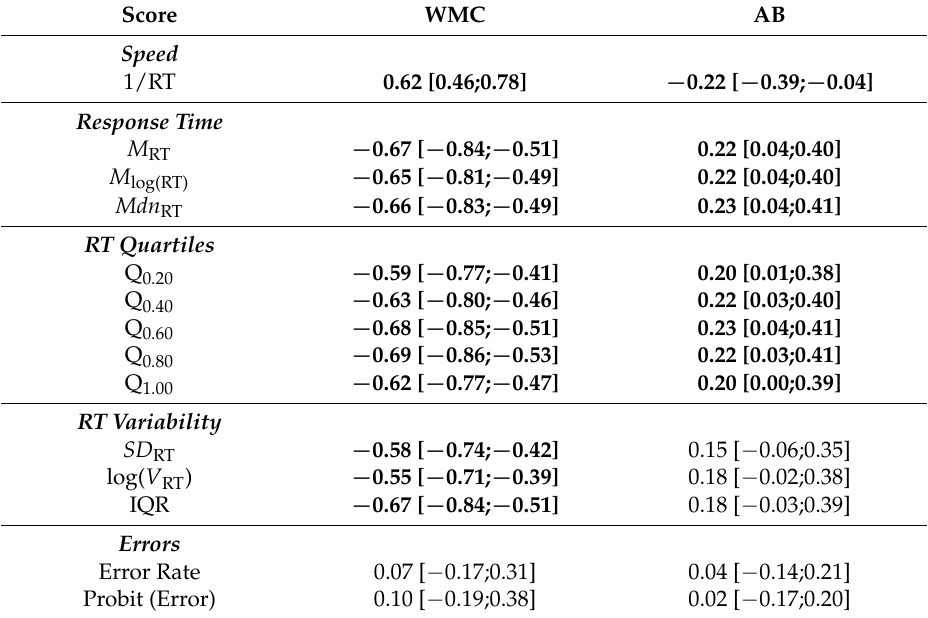
Table 2. Correlations of latent mental speed general factor with working memory capacity (WMC) and AB. Score